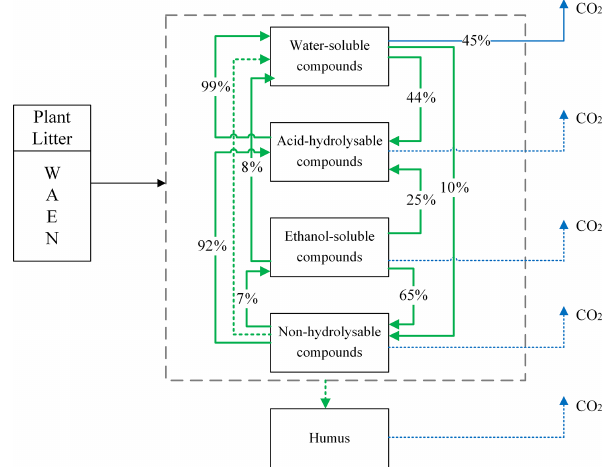
Figure 1. Conceptual diagram of decomposition and mass flows between five carbon pools in Yasso. In the original Yasso model (Tuomi et al., 2011a, b), the fate of organic matter entering soil as plant litter material is represented as a series of carbon fluxes between carbon pools characterized by distinct decomposability (i.e chemical solubility) levels. Values in arrows show the percentage of C transformed between pools and leaving the pools per yearly time step (%yr − 1 ) according to the original Yasso formulation and parameterizations (Tuomi, et al., 2011a; Viskari et al., 2020). Small flows are dotted